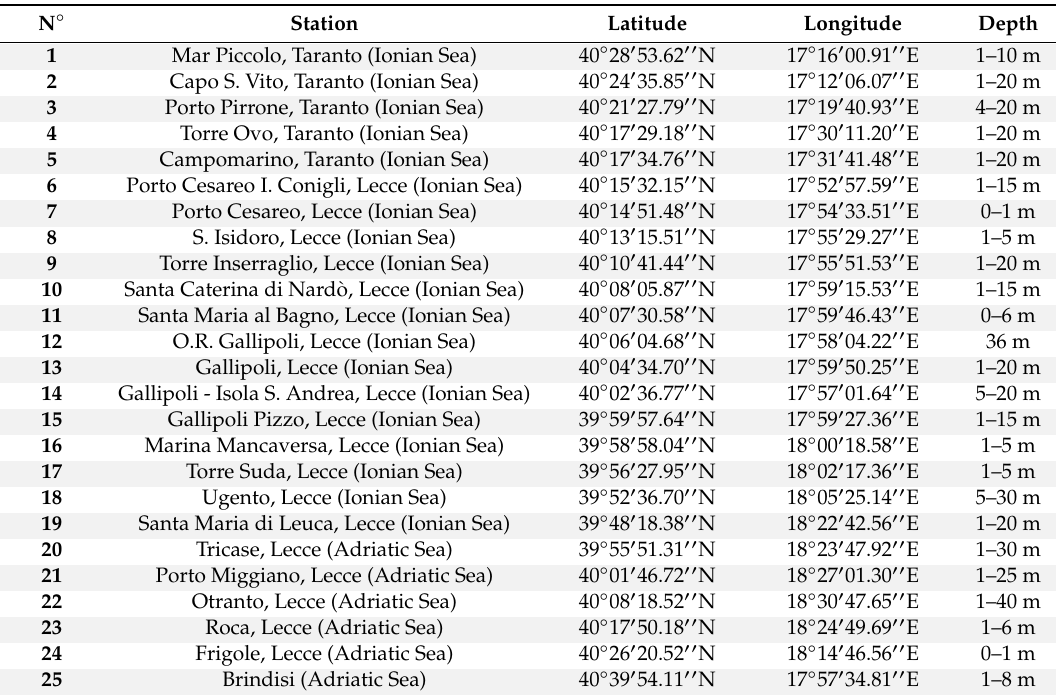
Table 2. List of species of Heterobranchia occurring around the Salento peninsula; localities are numbered according to Figure 1, with new records in column D, highlighted in bold. Column A = Perrone [30–37]; B = Onorato and Belmonte [38]; C = Micaroni et al. [39]; and D = Present study.